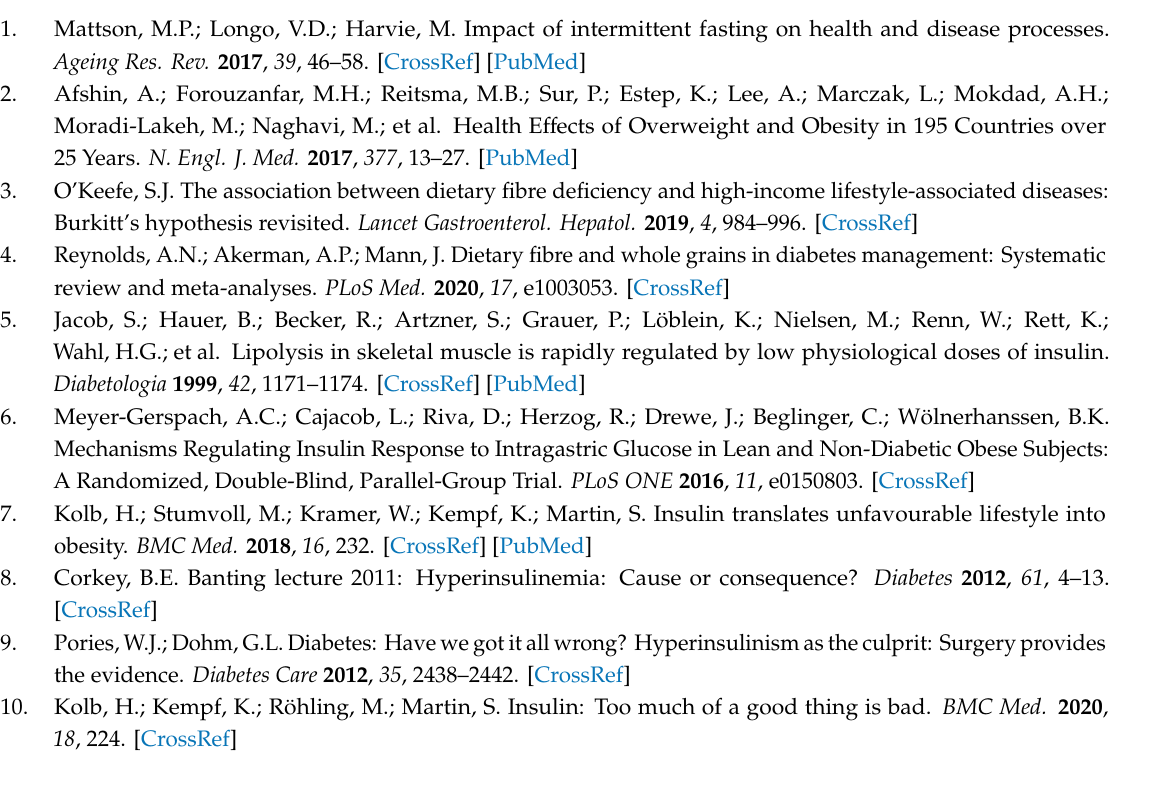
Figure S1: Detailed summary of all measurements, outcomes and time points for SI and WL, Figure S2: Mean changes in the present RCT compared to a confirmative single-arm trial, Table S1: Intra-group changes in the WL-group between waiting and intervention